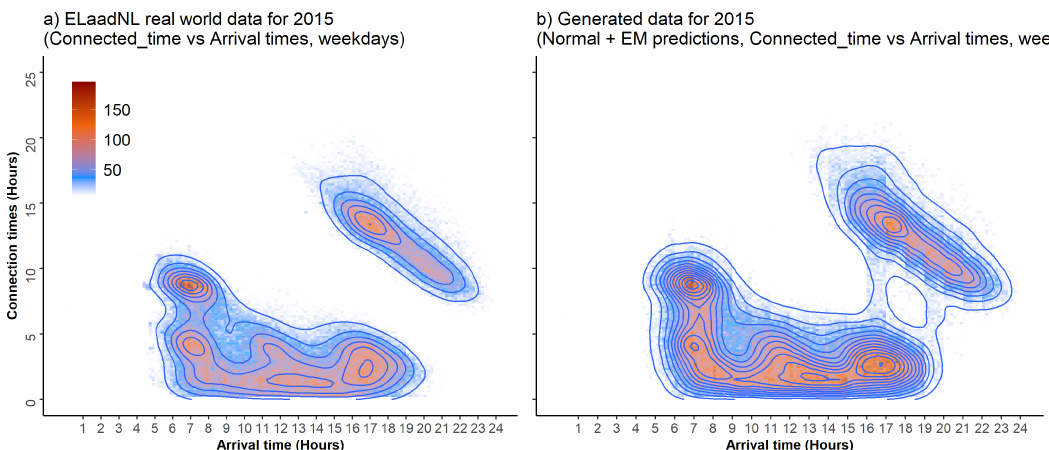
Figure 8. Density plots for connection times (2015, weekdays). Generated data represent sampled connection times for real-world EV arrivals. Each point represents a bin (10 min by 10 min), and is colored based on the number of EV sessions in the bin (bins with less than 5 arrivals were not plotted to keep the graph readable).